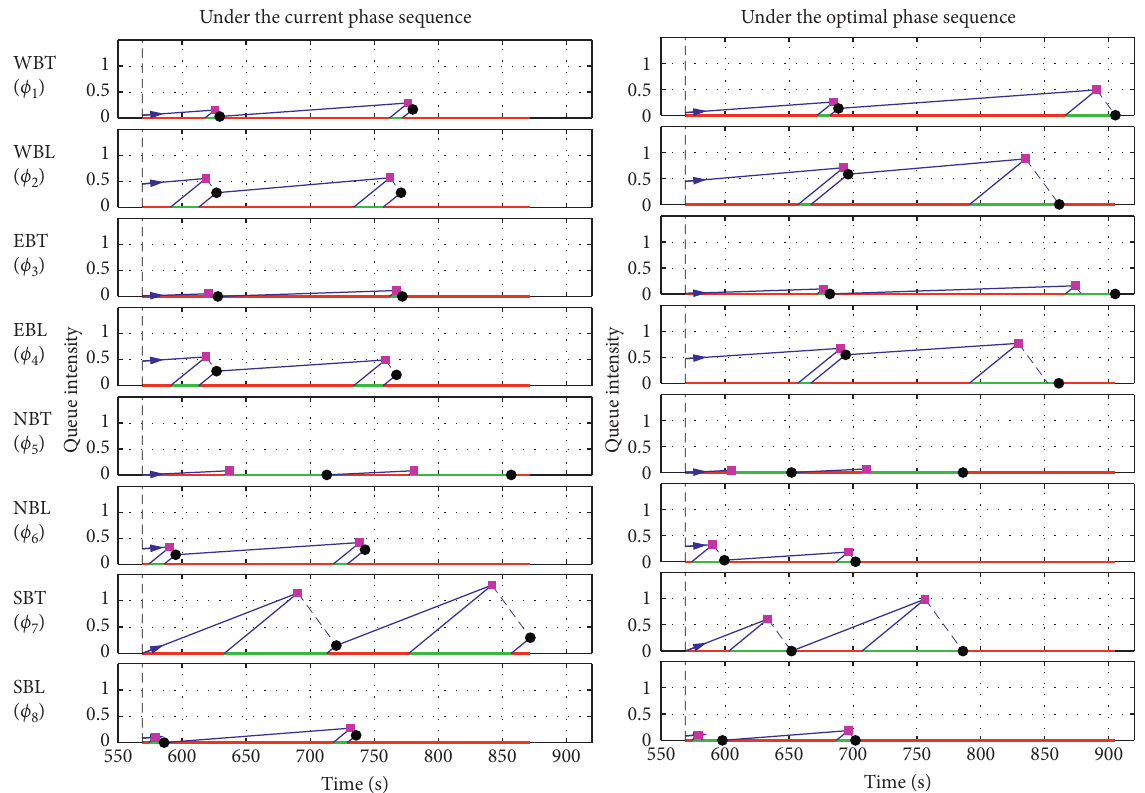
Figure 6: Illustrations of QIA optimization under two typical phase sequences at decision point t �